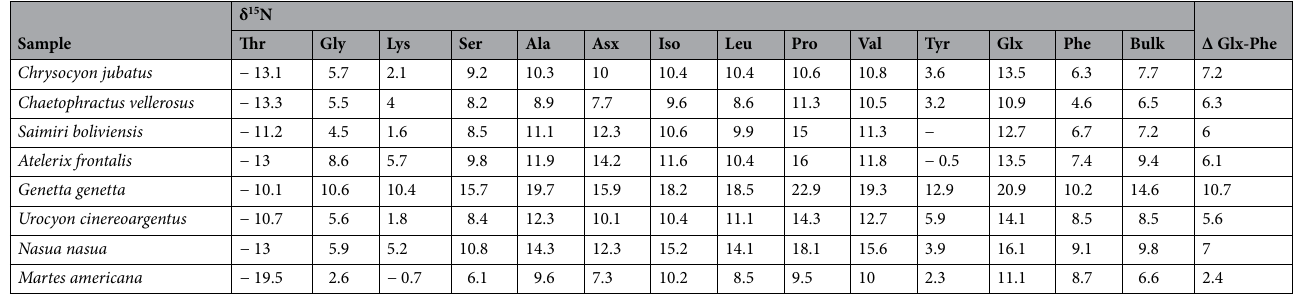
Table 2. AA and bulk δ 15 N values (‰ vs. AIR) for the eight modern omnivorous mammalian species analyzed. ∆Glx-Phe as in Table